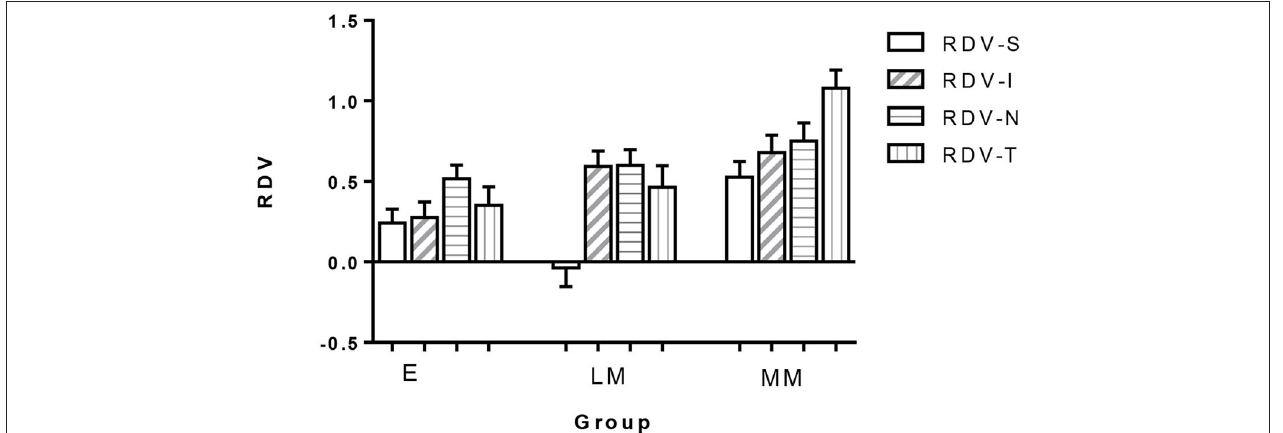
FIGURE 6 | The RDV values [RDV-superior (RDV-S), RDV-inferior (RDV-I), RDV-temporal (RDV-T), and RDV-nasal (RDV-N)] in the peripheral retina of the three groups. In the RDV-S position, there was a significant difference in the value of RDV-S between Group LM and Group MM ( P < 0.05); In the RDV-I position, there was a significant difference in the value of RDV-I between Group E vs. Group LM, and Group E vs. Group MM ( P < 0.05). In RDV-T position, there was no significant difference in the value of RDV-T among the three groups. In the RDV-N position, there was a significant difference in the value of RDV-N. between Group E vs. Group LM and Group E vs. Group MM ( P < 0.05).